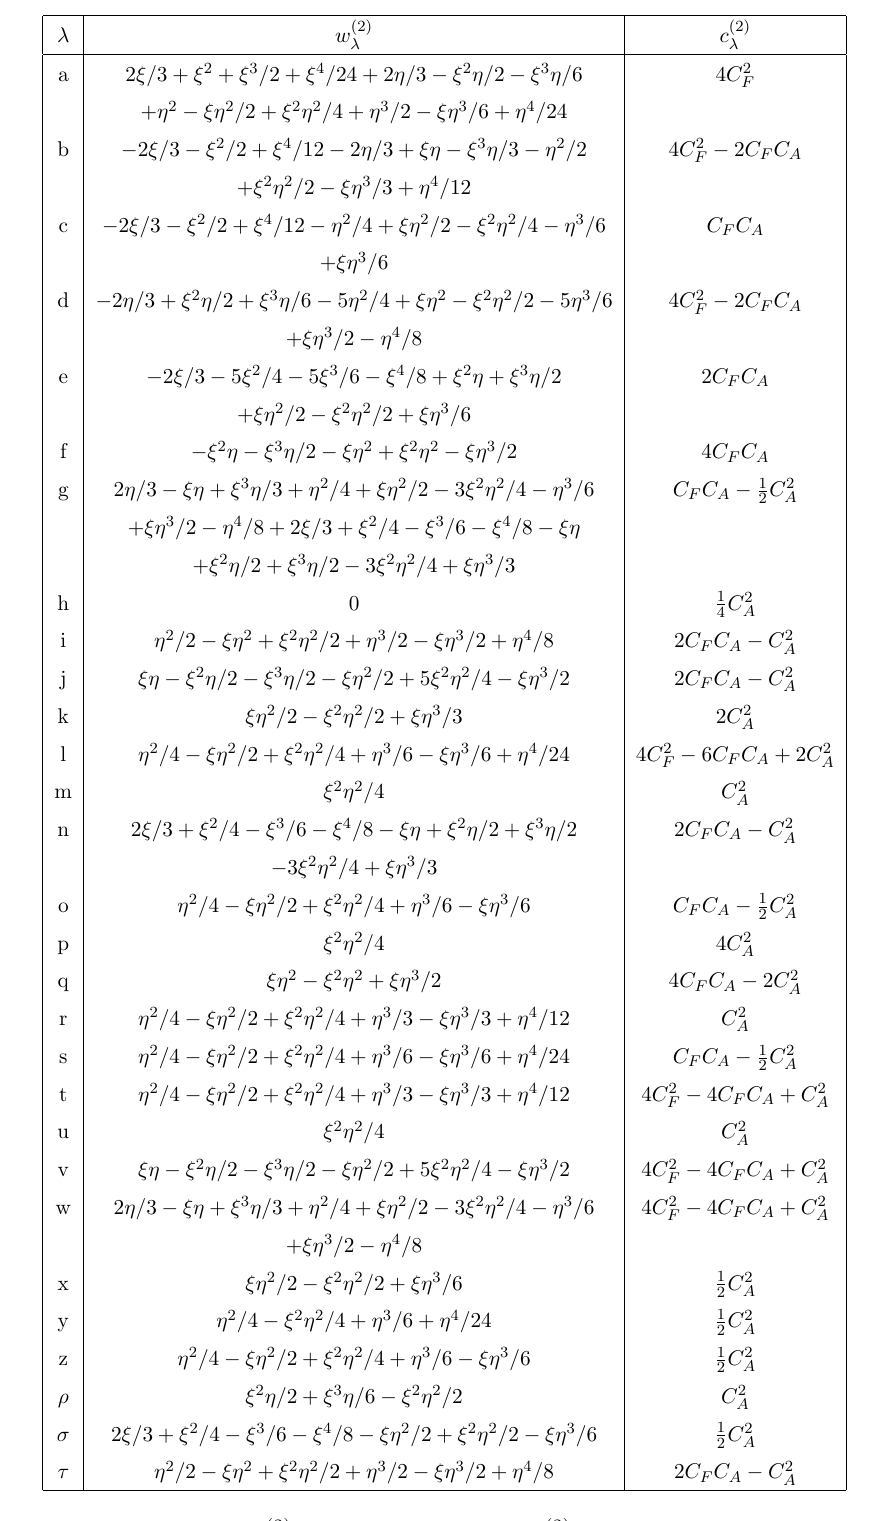
Table 2 . The weights w (2)